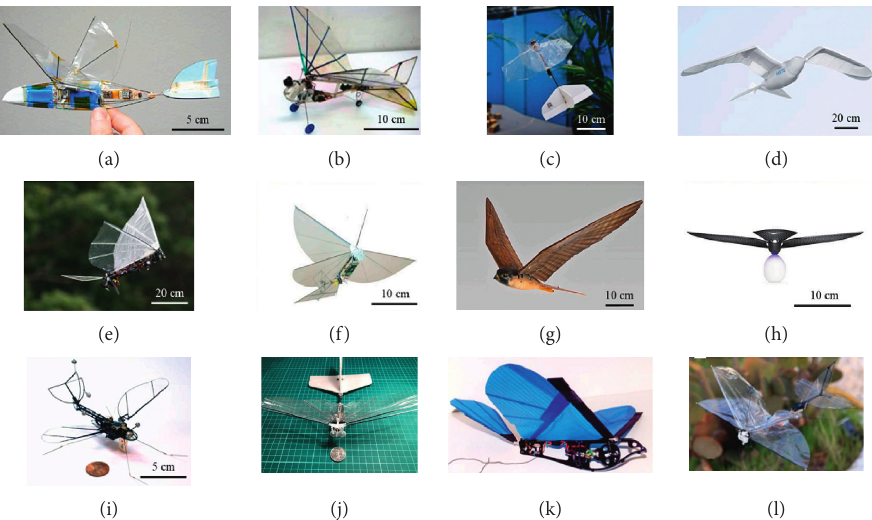
Figure 3: Examples of existing bird-inspired tailed FWAVs. (a) Microbat from AeroVironment Inc. [26]. (b) 32g ornithopter from Konkuk University [27]. (c) DelFly Explorer from the Delft University of Technology [28]. (d) SmartBird from Festo AG & Co. KG [29]. (e). Robo Raven V from the University of Maryland [30]. (f) H2Bird ornithopter from the University of California, Berkeley [31]. (g) Robird from Clear Flight Solutions and the University of Twente [32]. (h) BionicBird from http://bionicbird.com. (i) 3.2g flapping-wing platform from Harvard University [33]. (j) NAV from the American University of Sharjah [34]. (k) Slow Hawk 2 from Kinkade R/C. (l) Butterfly’s spy drone from Israel Aircraft Industries (IAI)